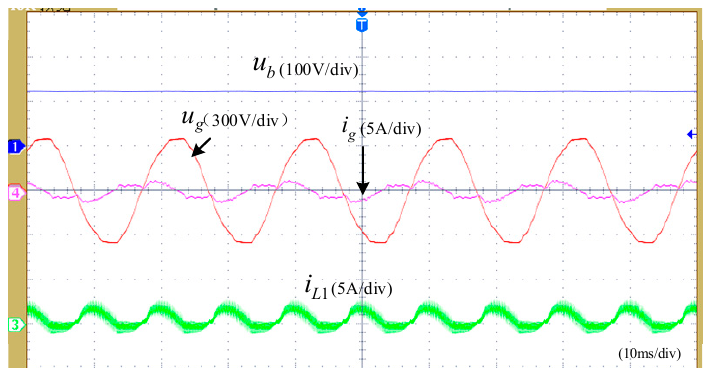
Figure 10. The experimental waveform of the presented converter operating in the charging mode ( P = 200 W, Q = − 340 var, cos ϕ = 0.5 ).